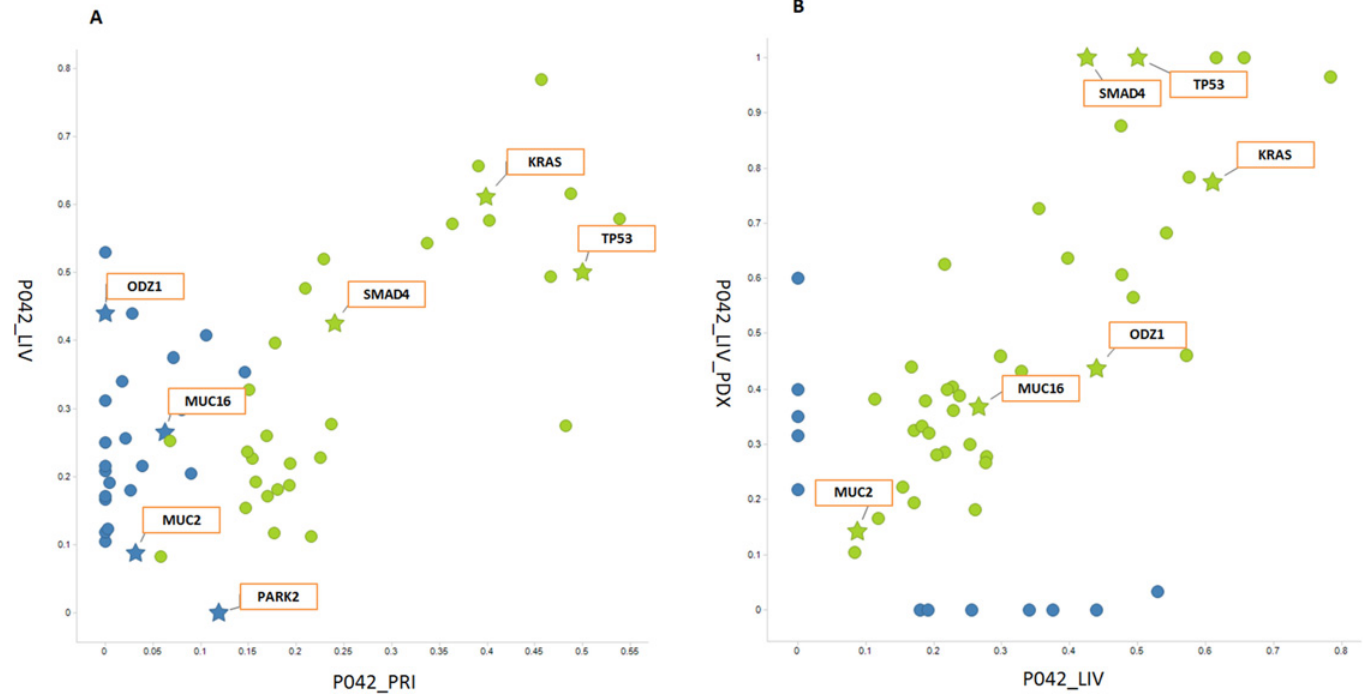
Fig 3. Scatter plots of non-synonymous and non-sense mutations for (A) P042_PRI vs. P042_LIV and (B) P042_LIV vs. P042_LIV_PDX. The plots are based on the mutant allele frequencies (MAFs, from 0 to 1)) of non-synonymous and non-sense mutations from the paired samples. The mutations that are called in both samples are marked by green dots, while ones called in only one sample are colored blue. Gene names are shown for those key mutations discussed in the text.